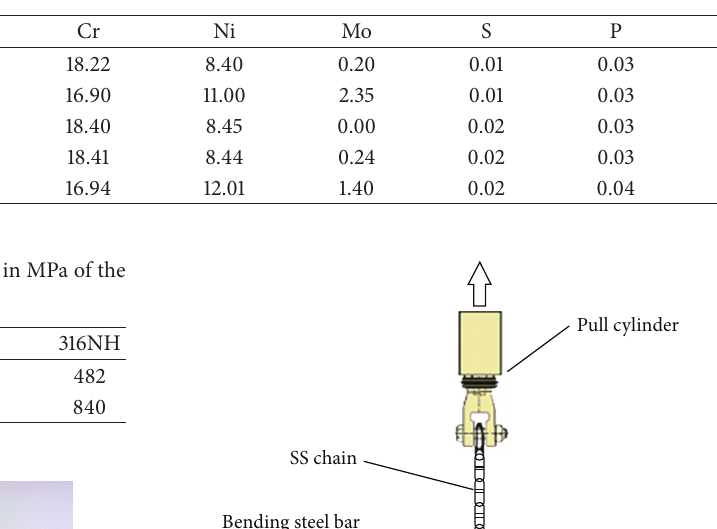
Table 2: Chemical composition of stainless steel specimens.